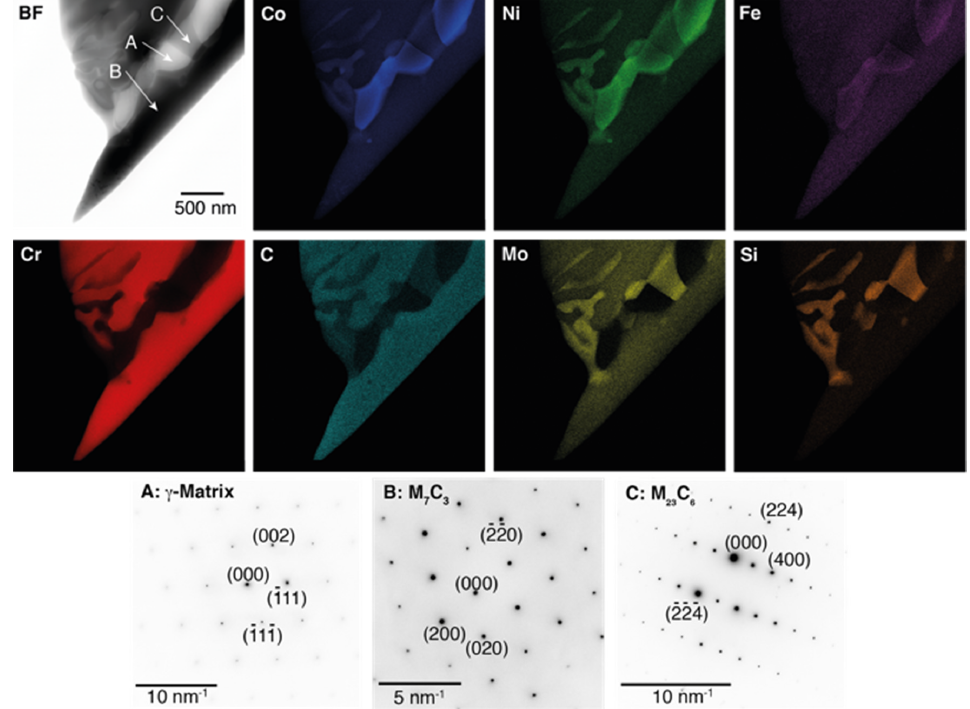
Figure 3. Bright field (BF) image of a region of interest in Co-101 with corresponding STEM-EDX elemental distribution maps of Co, Ni, Fe, Cr, C, Mo and Si. SADPs of the major phases in Co-101, labelled A, B and C in the BF image, were identified as the γ matrix, M 7 C 3 and M 23 C 6 with zone axes [110], [0001] and [0 8(cid:3364) 4], respectively.